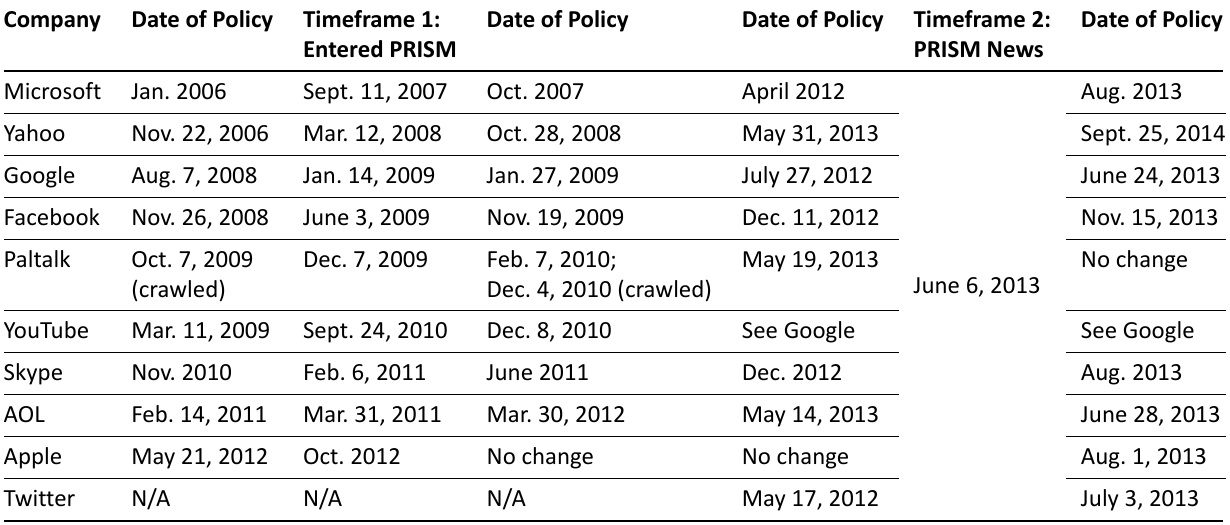
Table 1. Privacy policies analyzed across two time frames.